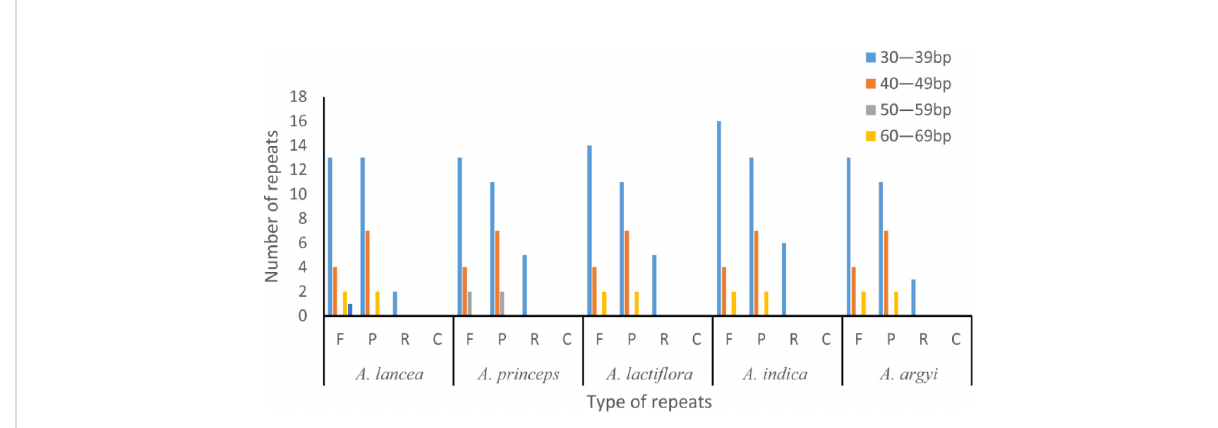
FIGURE 2 Long repeat sequence analysis of the genomes of fi ve Artemisia species. F, forward repeat; P, palindromic repeat; R, reverse repeat; C, complementary